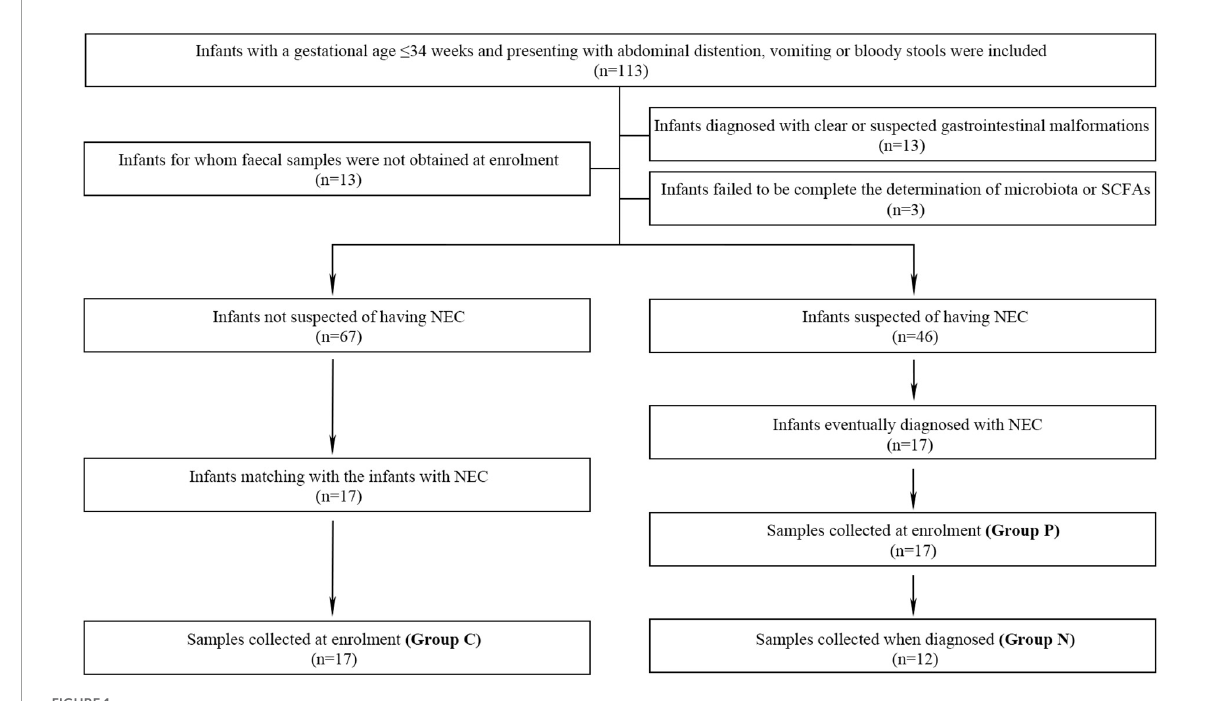
FIGURE1 The inclusion, exclusion and grouping processes of the